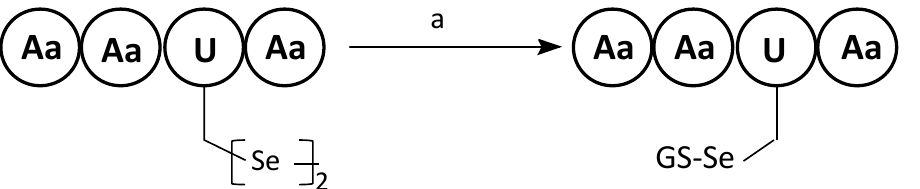
Scheme 9. Photochemical formation of selenosulfide bond (condition (a): Diselenide (1 equiv.), GSH (10 equiv.), RB (Rose Bengal) (0.1 equiv.), LED 460 , MeCN/H 2 O).